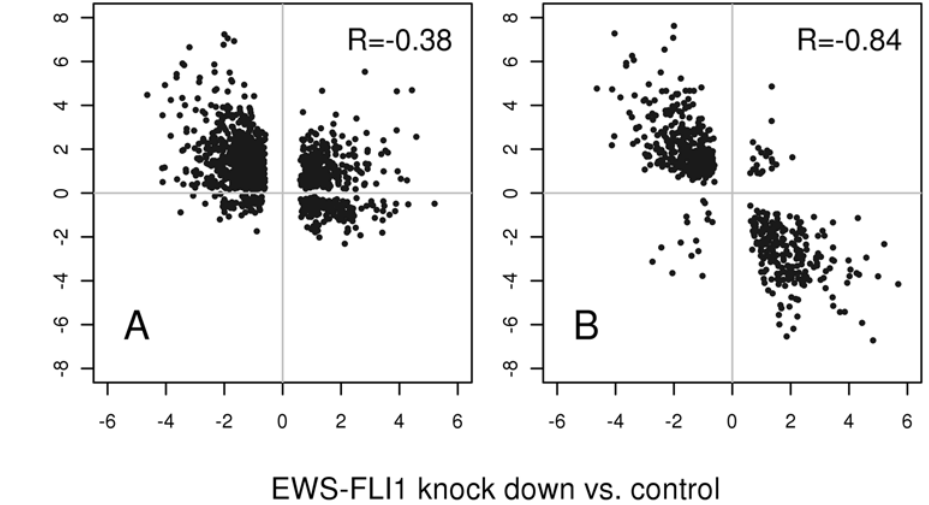
Figure 2. D KD- D ET plot. Plot of relative gene expression values of the EWS-FLI1 knockdown compared to control ( D KD, x-axis) and ESFT compared to reference ( D ET, y-axis). (A) reference=the mean of all tissues in the Novartis gene expression atlas, (B) reference=human mesenchymal progenitor cells (MPC). Genes for this plot were selected by applying an adjusted p-value cut-off: P , 0.1 for D KD and D ET. The Pearson correlation coefficients (R) between D KD and D ET are indicated in the boxes.